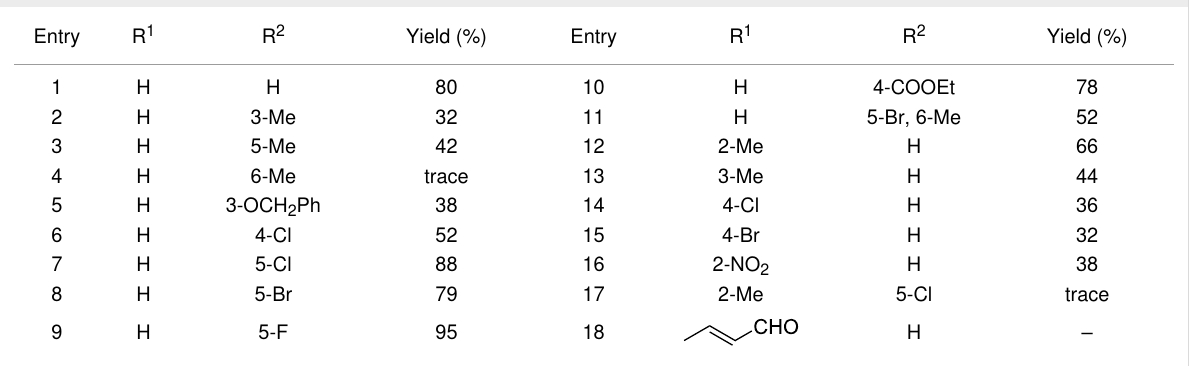
Table 1: Effect of substituents on product